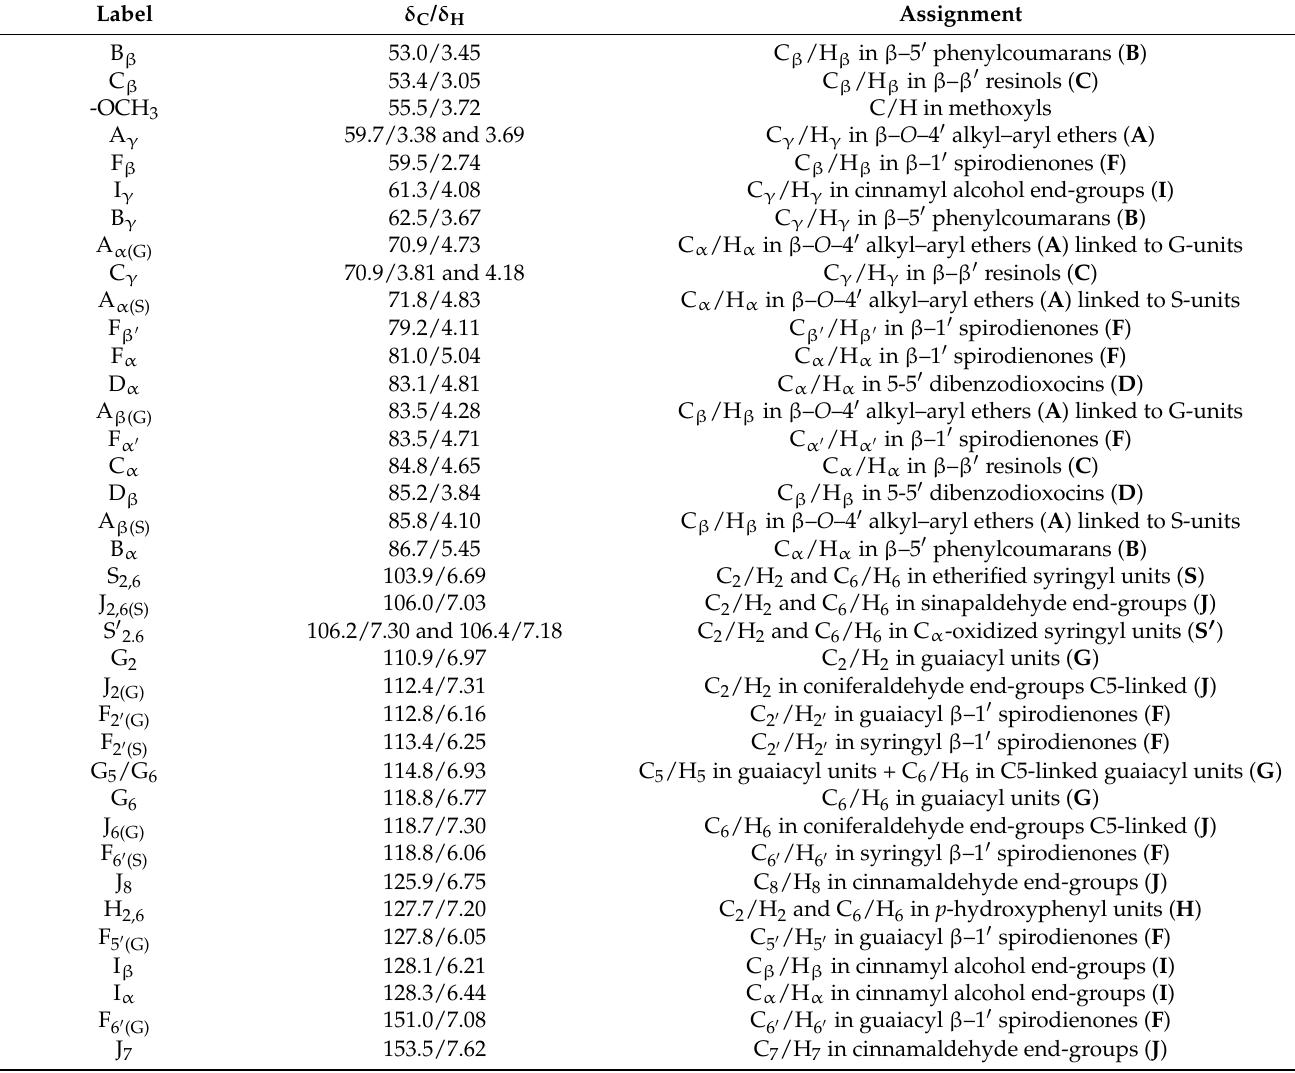
Table 3. Assignments of 13 C/ 1 H correlation signals in the 2D-NMR (HSQC) spectrum of the